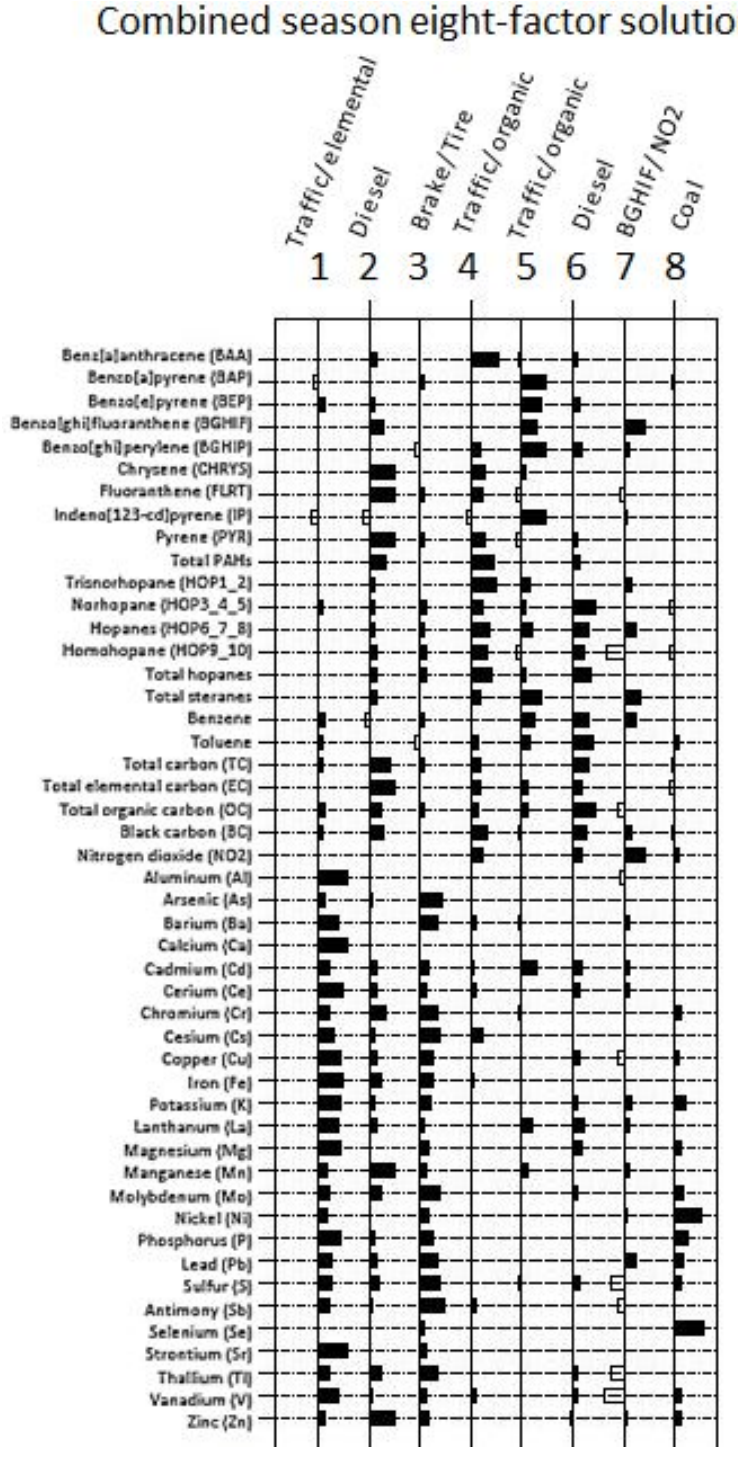
Figure 2. Factor loadings plot for eight-factor solution based on combined winter and summer pollutants ( n = 72).